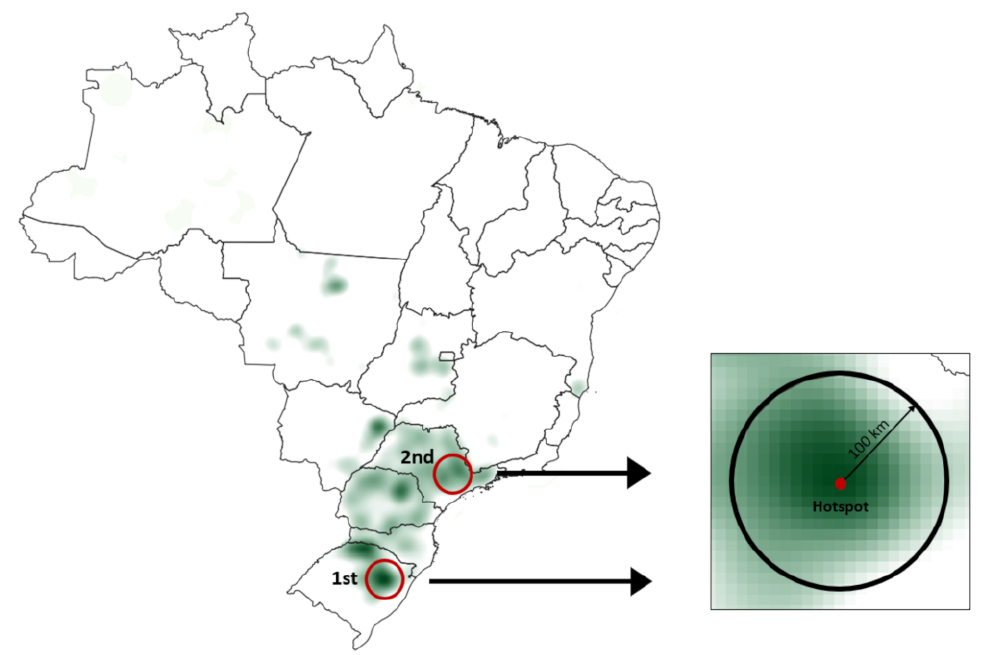
Figure 2. Hotspot’s potential identification (Brazilian map used as an